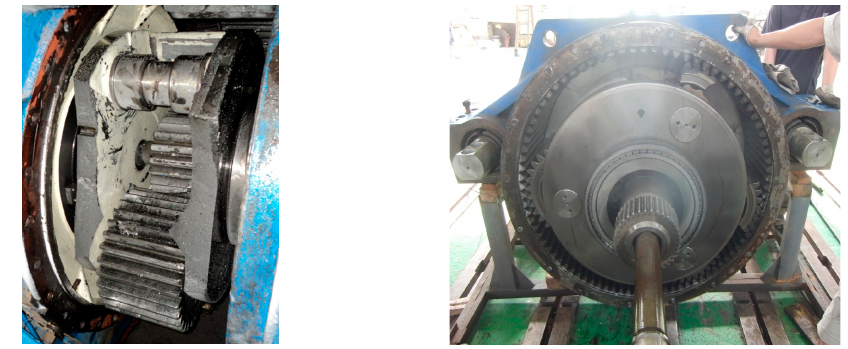
Figure 19. Damaged wind turbine gearbox due to planet gears failure.